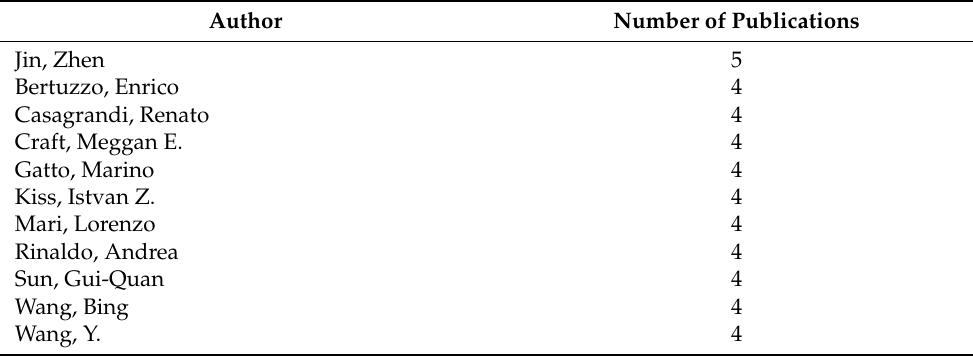
Table 2. Authors with the most published